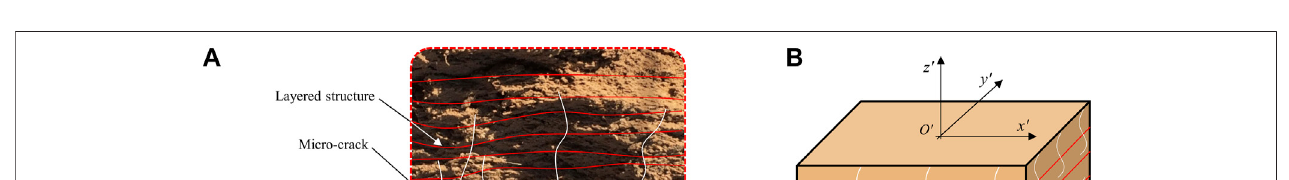
FIGURE 3 | Method for slope stability analysis considering water sensitivity.